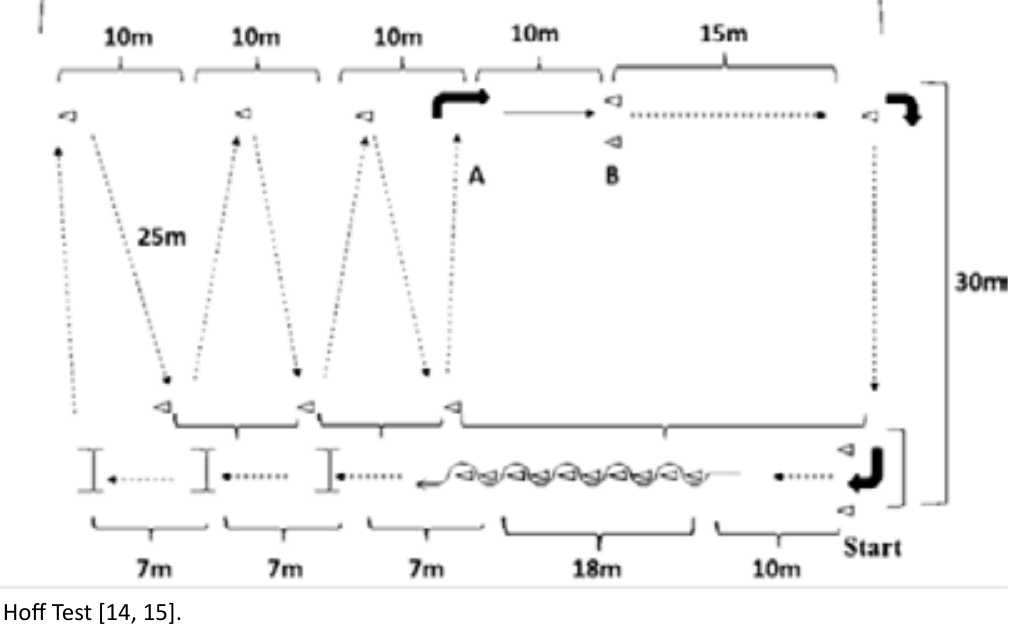
Figure 1 . The Hoff Test [14, 15].